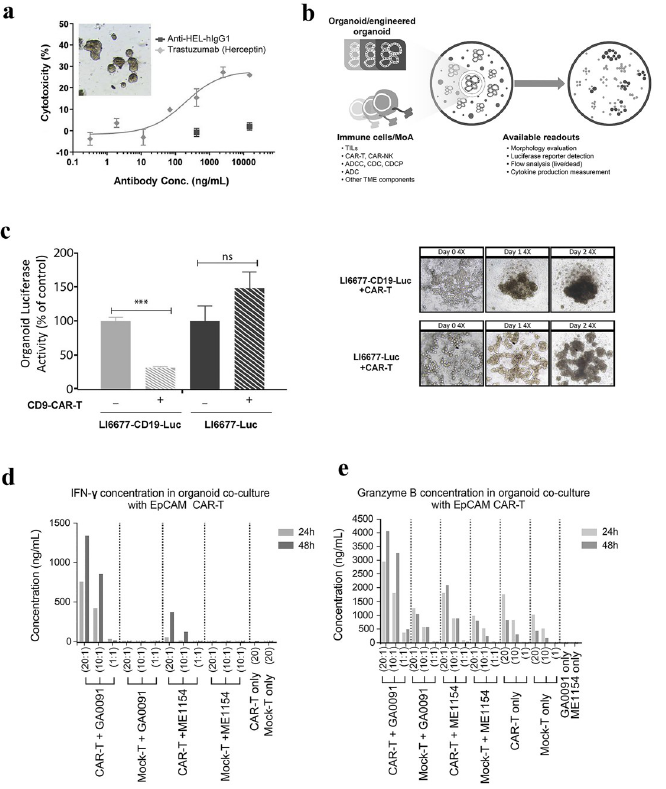
Fig 5. Co-culture of PDXOs with immune cells. a) ADCC-mediated killing of HER2 + ovarian tumor organoid OV0250 (inset bright field image of organoid culture) was determined via co-culture with PBMCs and Herceptin ™ and quantified by flow cytometry (mean % cytotoxicity ± SEM); b) Schematic of co-culture systems with immune cells or mechanism of action (MoA) and different types of endpoint readout; c) CAR-T cell mediated specific killing of liver cancer organoid (PDXO-LI6677) engineered to express both human CD19 and luciferase (grey shaded bars) or just luciferase (black shaded bars) co-cultured with (hatched bars) and without (solid bars) CD19 CAR-T cells at 1:10 ratio for 2 days with luciferase activity used to track organoid growth/killing (% of control without CAR-T ± SEM). Representative bright field images (4x magnification) shown on right to show morphology changes in the coculture of LI6677-CD19-luc PDXOs (top images) or LI6677-luc PDXOs (bottom images) at different timepoints. d) Co-culture of EpCAM + gastric cancer organoid (PDXO-GA0091) with EpCAM-CAR-T cells led to CAR-T cell activation/ mediated killing, compared to the EpCAM - melanoma organoid (PDXO ME1154) as measured by d) IFN γ and e) Granzyme B ELISA over 24 (grey bars) and 48 (black bars) hours.